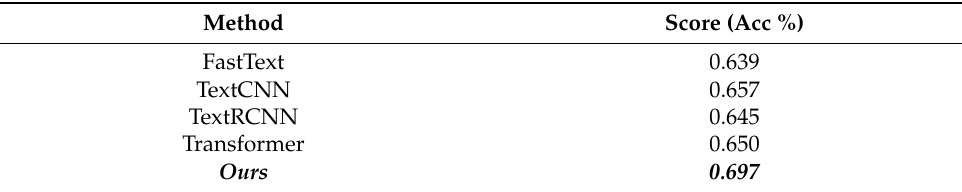
Table 3. Model evaluation of sentiment